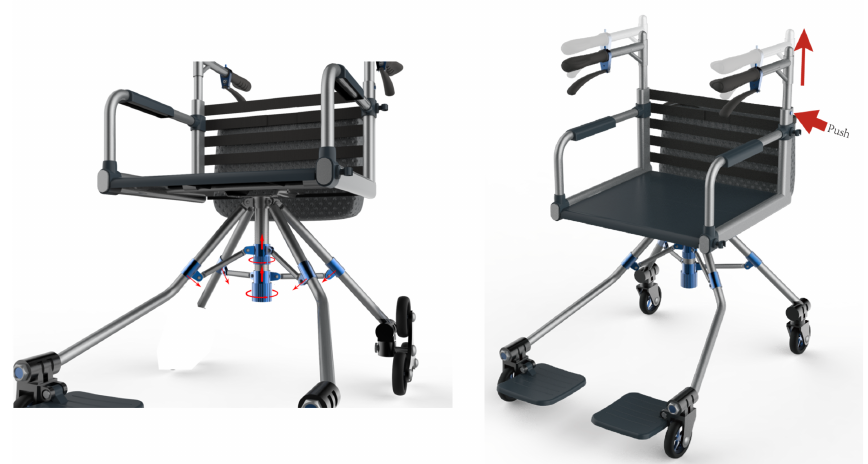
Figure 5. The adjustment of height and handle.